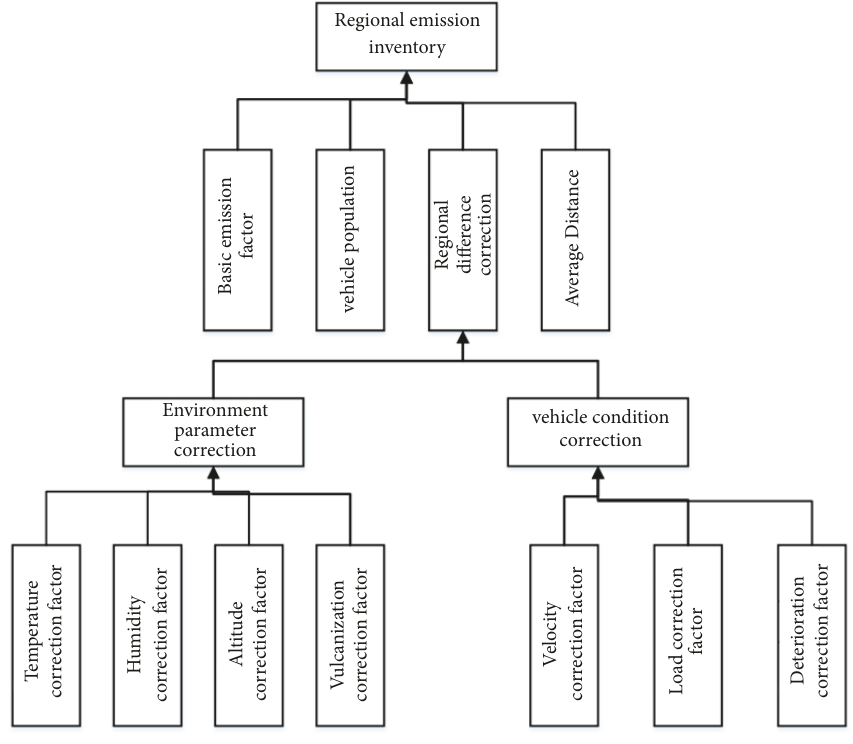
Figure 1: Model calculation flowchart.